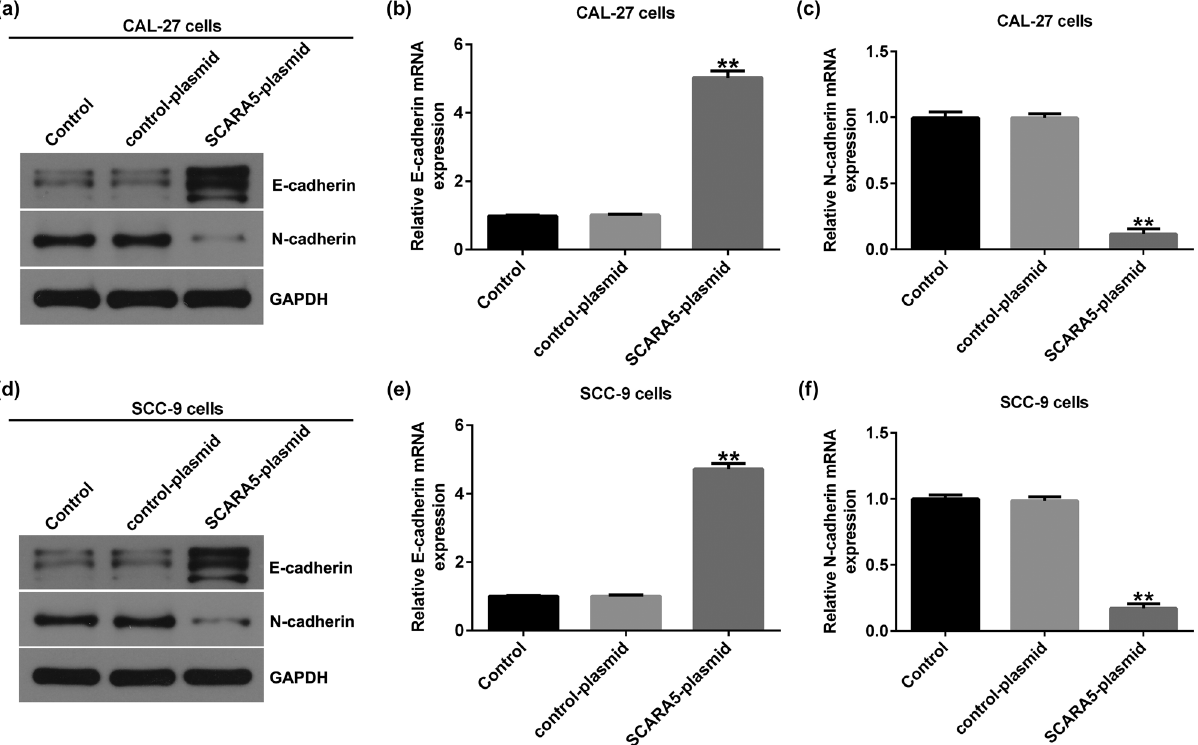
Figure 4: The e ff ect of SCARA5 on EMT in OSCC cells. ( a ) Western blot analysis of E - cadherin and N - cadherin expression at protein level in CAL - 27 cells. qRT - PCR assay of E - cadherin expression ( b ) and N - cadherin expression ( c ) at mRNA level in CAL - 27 cells. ( d ) Western blot analysis of E - cadherin and N - cadherin expression in SCC - 9 cells. qRT - PCR assay of E - cadherin expression ( e ) and N - cadherin expression ( f ) in SCC - 9 cells. ** p < 0.01 vs control plasmid. ** p < 0.01 vs control